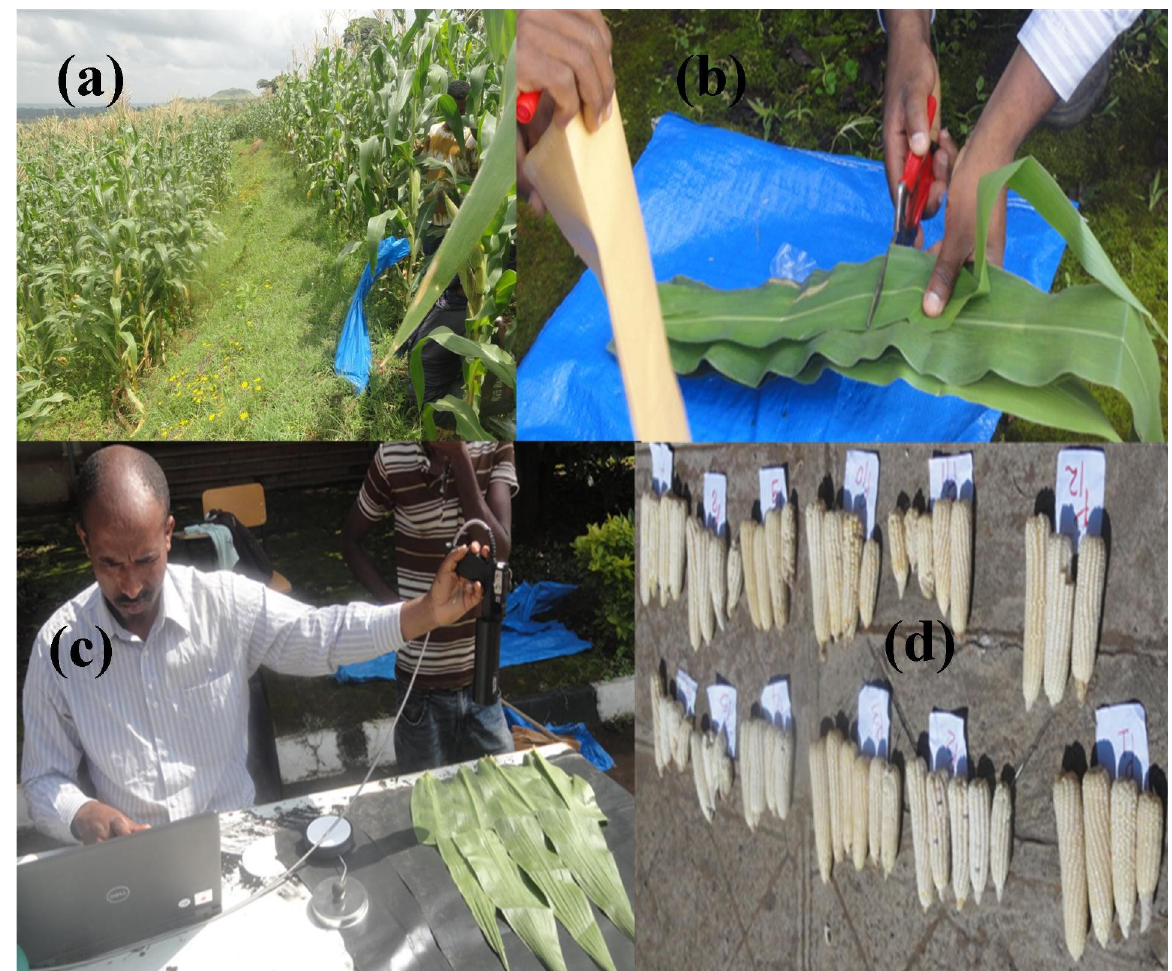
Fig 2. Crop sampling and reflectance measurement: (a) Maize crop sampling, (b) Sample preparation, (c) Crop reflectance measurement with a spectroradiometer, and (d) Cobs for grain weight measurement.